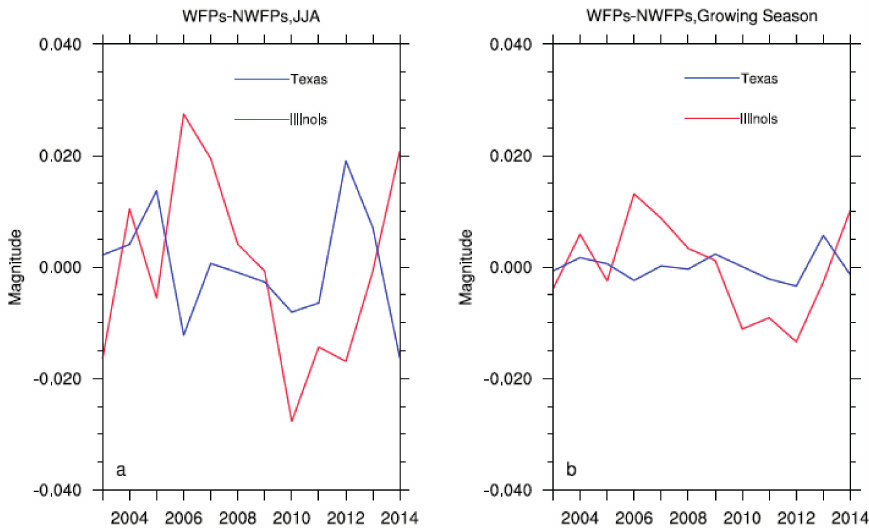
Figure 8. Interannual variations in areal mean ∆ EVI (WFPs minus NWFPs) in Illinois and Texas for the period 2003–2014 during ( a ) JJA and ( b ) the growing